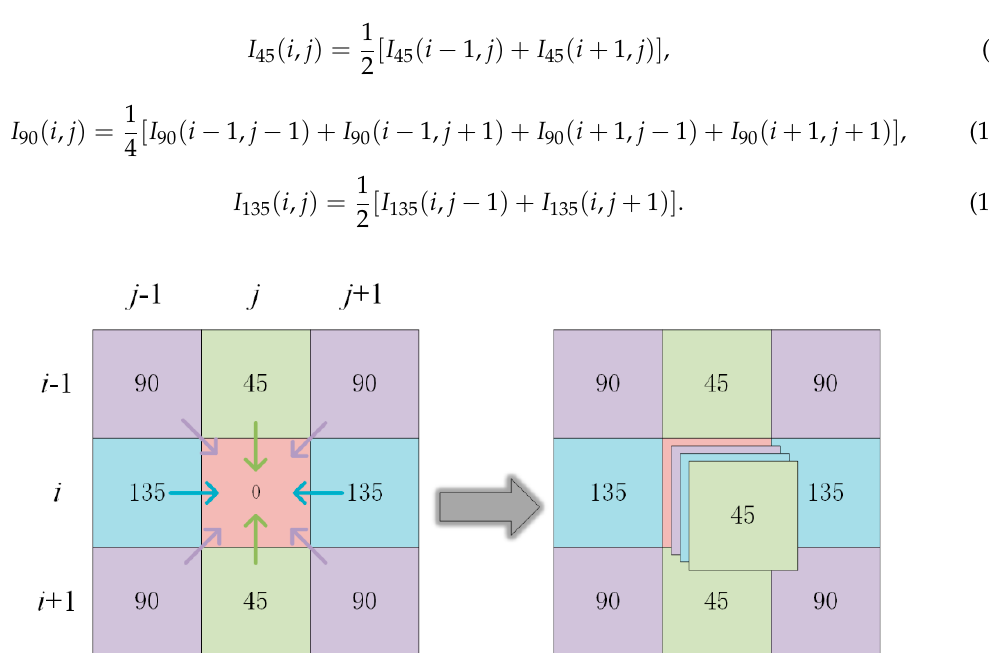
Figure 5. Diagram of bilinear interpolation method in DoFP polarization image sensor .